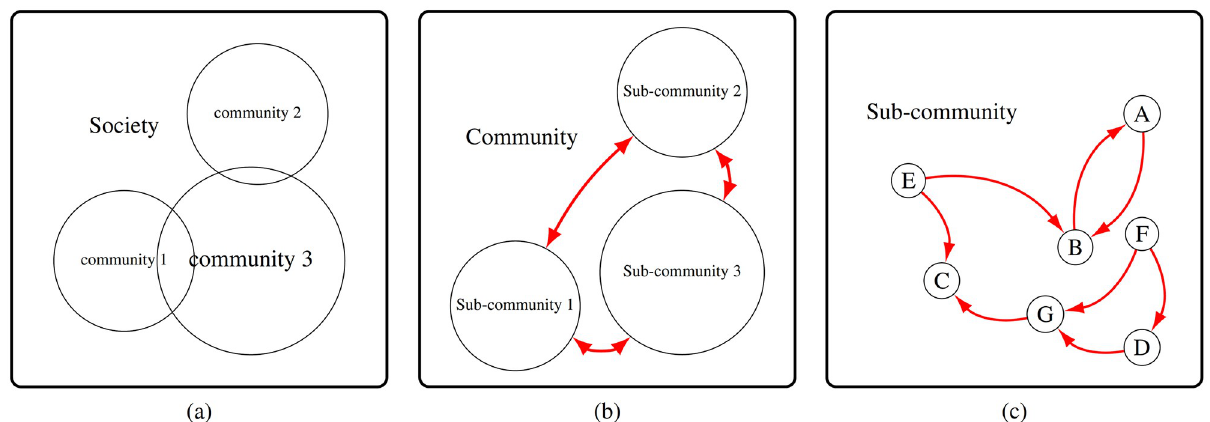
Fig 3. (a) In the first phase, all individuals of the society are created based on the population size and the set of provided family patterns, as explained in Section 1.2.1. (b) The abstract hierarchical structure of the communities and subcommunities of the society is created. Observe that communities may be intersecting as an individual may be a member of various communities such as family, school, restaurant, etc. Within a community, there are two types of interactions shown as red arrows. One type of interaction is inter-subcommunity, such as the interactions among teachers and students in a school. Note that, inter-subcommunity edges are indeed directional and here for ease of depiction are shown in this way. (c) Another type of interaction, shown with red arrows, is within a subcommunity. For example, the way students interact with each other in a school.